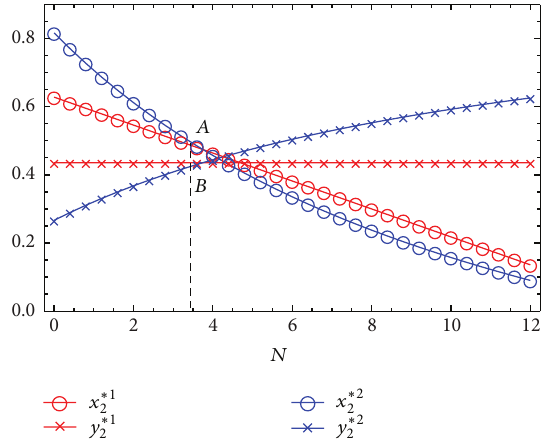
Figure 10: The changes of 𝑥 ∗ 2 and 𝑦 ∗ 2 as 𝑁 changes in compensation mechanisms 2 and